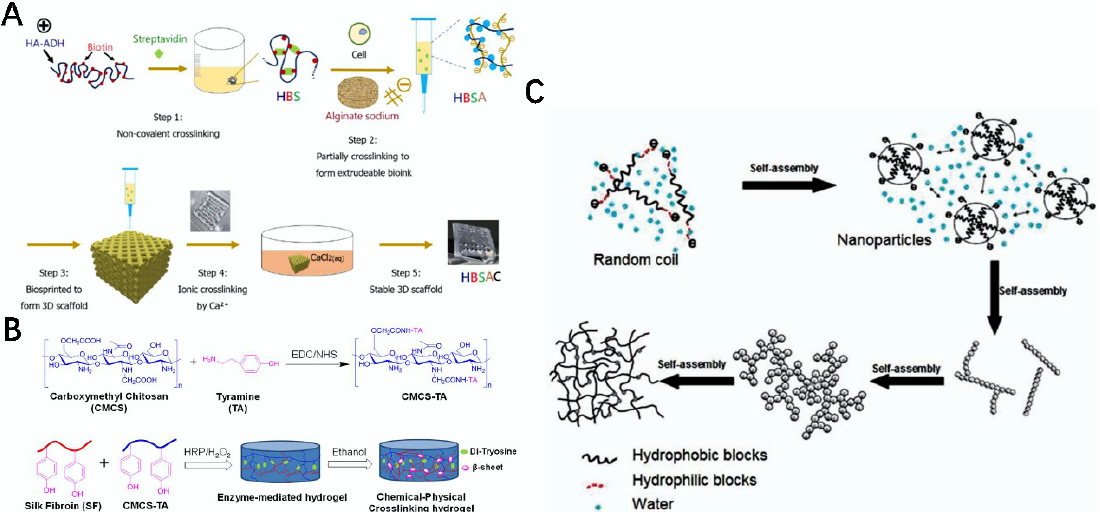
Figure 6. Processing and modification of natural biological materials. ( A ) Schematic diagram of HBSAC hydrogel scaffold prepared via Ca 2+ modification [113]. ( B ) Schematic diagram of the preparation of CMCS-TA hydrogels under HRP operation [114]. ( C ) Schematic diagram of the protein self-assembly of silk fibroin in aqueous solution [115].